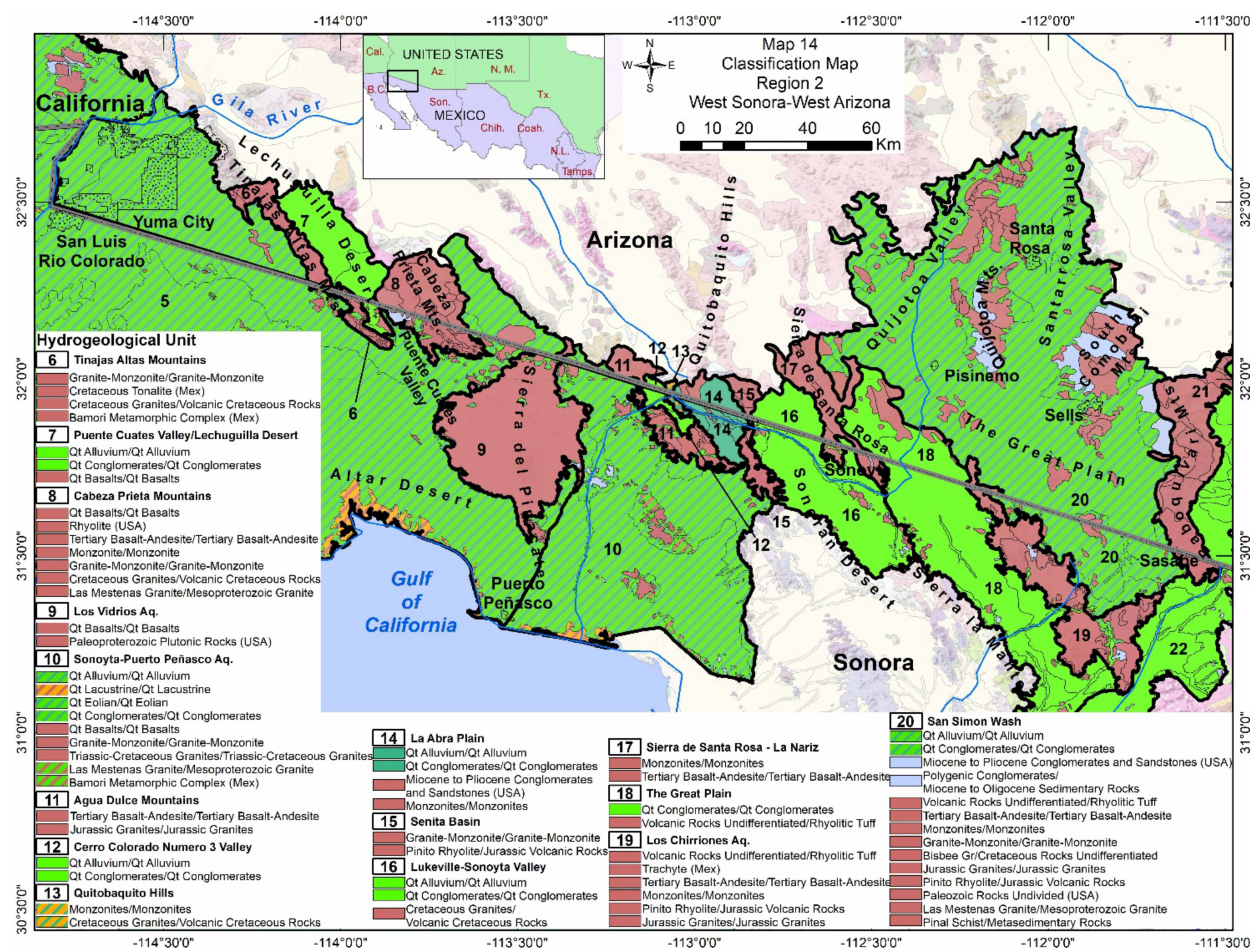
Figure 14. Classification map, West Sonora—West